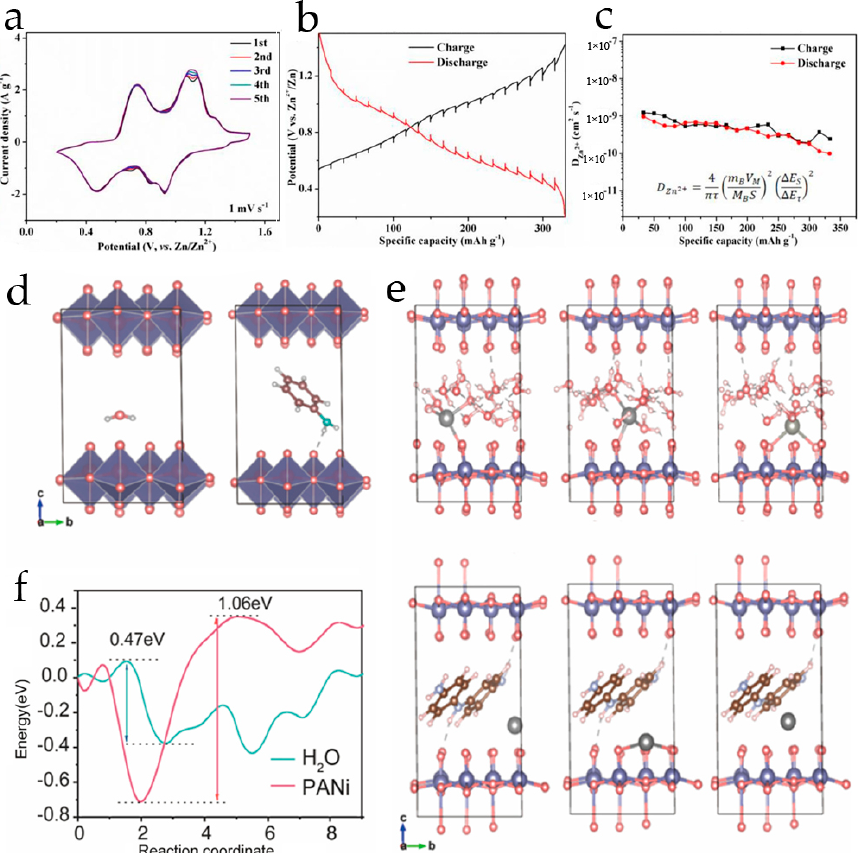
Figure 3. ( a ) CV curves of PANI/V 2 O 5 composite in the first five cycles at 1 mV · s − 1 [54]; ( b ) The GITT curves and ( c ) the calculated diffusion coefficient of Zn 2+ of PANI/V 2 O 5 composite [54]; ( d ) Models for calculating binding energies of water- and aniline-intercalated V 2 O 5 matrix [63]; ( e ) possible Zn ion migration pathway in VHO and PAVO. Blue, red, and grey balls represent V, O, and Zn atoms, respectively [63]; ( f ) energy barriers along Zn migration pathways for VHO and PAVO [63].